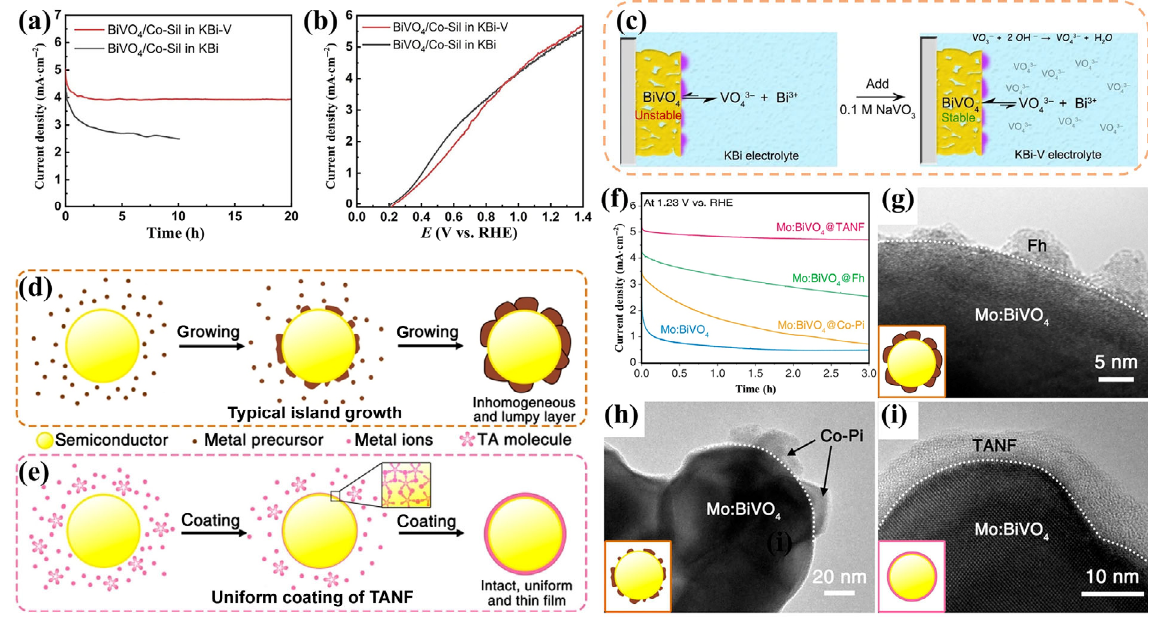
Figure 6 (a) I – T curves at 1.23 V vs. RHE, (b) J – V curves and (c) schematic diagram of photoetching in KBi and KBi-V at pH = 9.5. Reproduced with permission from Ref. [94], © Elsevier B.V. 2020. Growth schematic diagrams of (d) the island shape of the conventional cocatalyst and (e) the coated TANF. (f) I – T curves in 0.5 M borate buffer (pH = 8.5) at 1.23 V vs. RHE for 3 h. TEM images of Mo:BiVO 4 modified with (g) Fh, (h) Co-Pi, and (i) TANF. The insets in Panels (h)–(i) are the corresponding growth patterns of the cocatalyst. Reproduced with permission from Ref. [117], © American Chemical Society